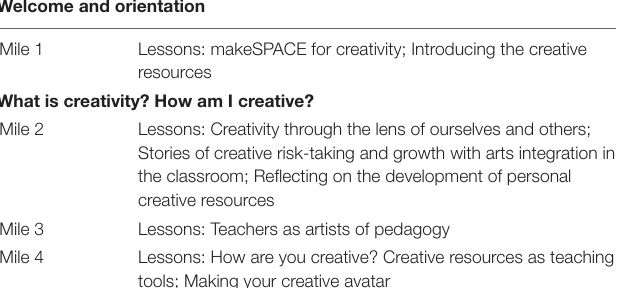
TABLE 1 | Scope and sequence for makeSPACE foundation course for creative engagement in arts integration—The river journey (metaphor used across the